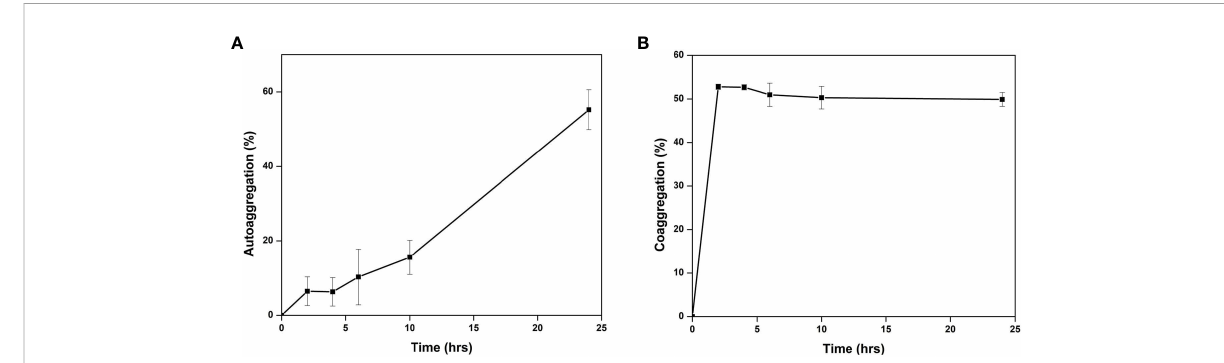
FIGURE 6 Auto-aggregation (A) and Co-aggregation (B) of Cellulomonas sp. HM71 with a pathogen mixture of E.coli, Staphylococcus aureus , and Salmonella typhim